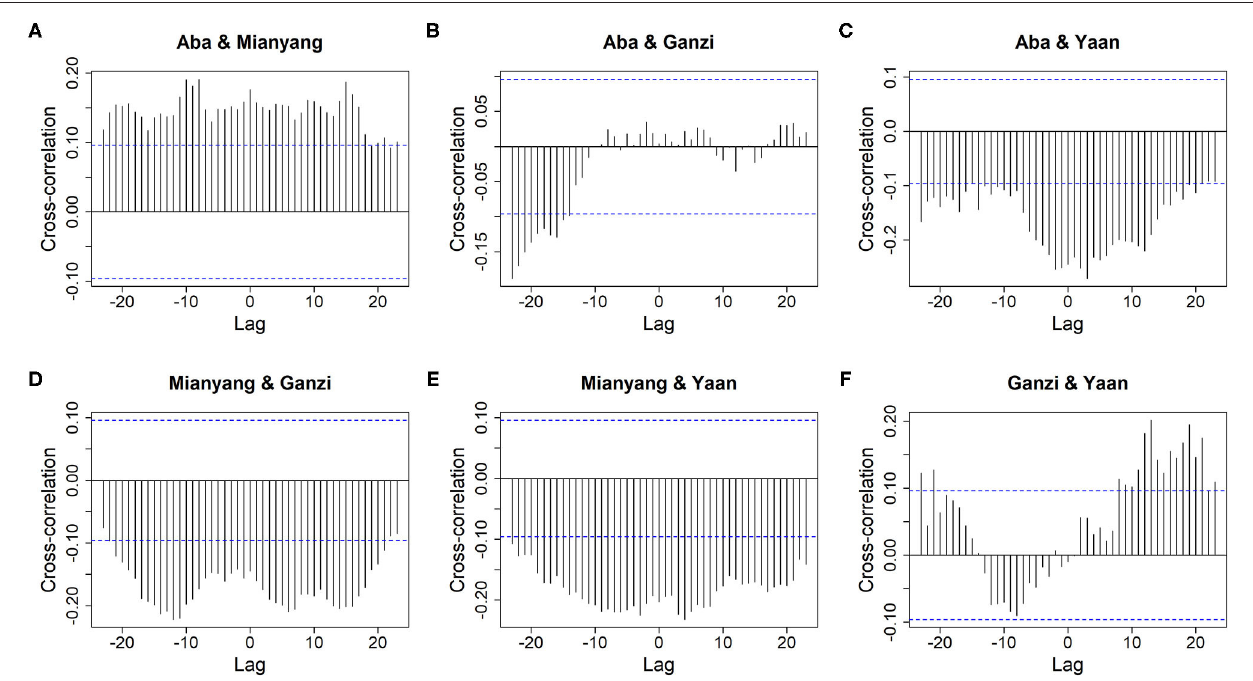
FIGURE 2 | The cross-correlation of ILI% between cities of cluster 1. (A) Aba and Mianyang. (B) Aba and Ganzi. (C) Aba and Ya’an. (D) Mianyang and Ganzi. (E) Mianyang and Ya’an. (F) Ganzi and Ya’an.